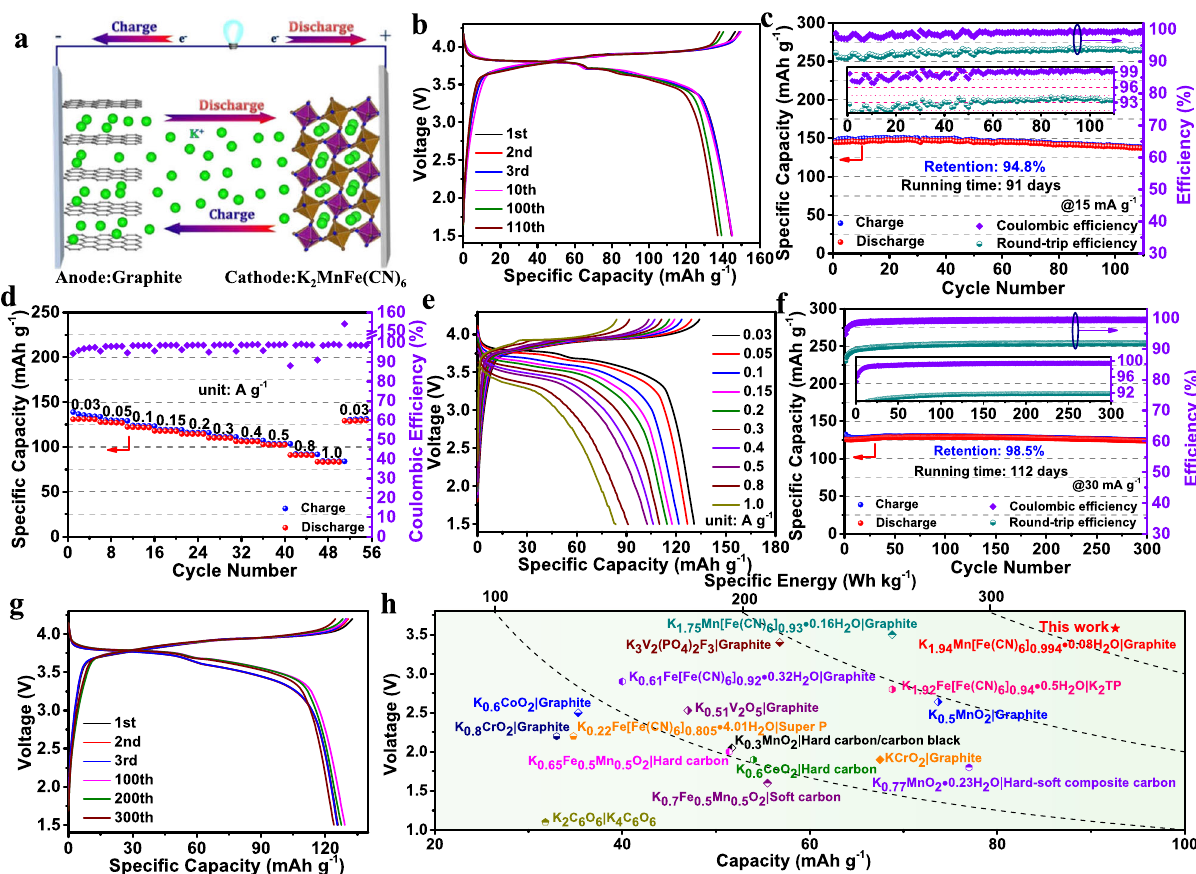
Fig. 5 K-ion full-cell performances in the 1.5 – 4.2 V voltage range. a A schematic illustration of the K-ion full cell. b , c Galvanostatic charge – discharge voltage pro fi les ( b ) and cycling performance ( c ) of the KMF-EDTA| | Cyc-graphite full-cell at 15 mA g − 1 (~0.1 C). d , e Rate capability ( d ) and voltage pro fi les ( e ) of the KMF-EDTA| | Cyc-graphite full-cell under a constant charge speci fi c current (0.03 A g − 1 ) with different discharge speci fi c currents from 0.03 to 1.0 A g − 1 . f , g Long-term cycling stability ( f ) and voltage pro fi les ( g ) of the KMF-EDTA| | Cyc-graphite full-cell at 30 mA g − 1 . The insets in c and f show the enlarged view of ef fi ciency. The speci fi c current and speci fi c capacity in b – g are calculated based on the mass of KMF-EDTA in the full-cell. h Average discharge voltage and speci fi c energy versus capacity of some reported K-ion full-cells. Note: both the capacity and speci fi c energy in h are calculated based on the total mass of the cathode and anode materials in the corresponding full-cells, and the data used for plotting h are listed in Supplementary Table